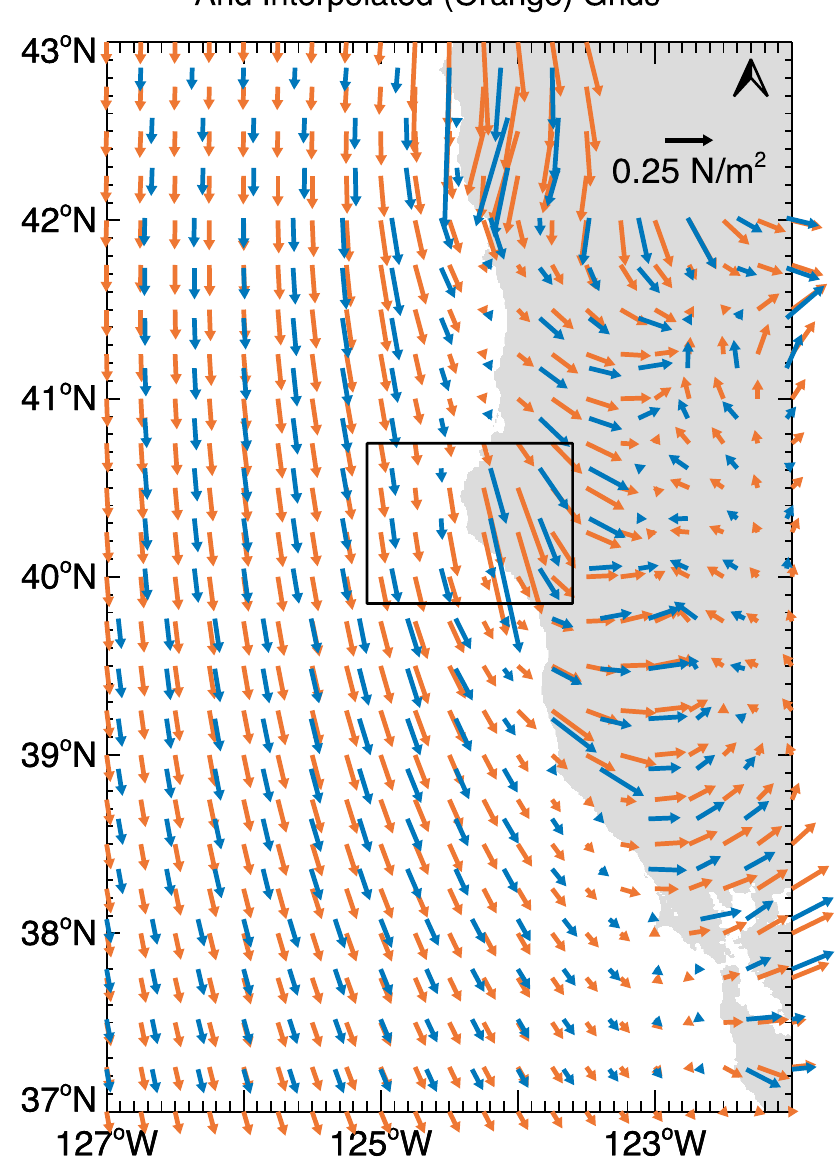
Figure 13. Average ERA-5 wind stress vectors for August 2005 on the native RGG grid of the model (blue) and on the interpolated regular lat-lon grid (orange). The box highlights the region around Cape Mendocino, where the blue equatorward wind stresses on the RGG grid decrease over water as land is approached and then increase greatly over land. In contrast, moving toward land at about 40.2 ◦ –40.4 ◦ N, the orange wind stresses on the interpolated lat-lon grid increase over water on two of the grid points closest to land, since they lie between a weaker RGG value of wind stress over water and a stronger RGG wind stress over